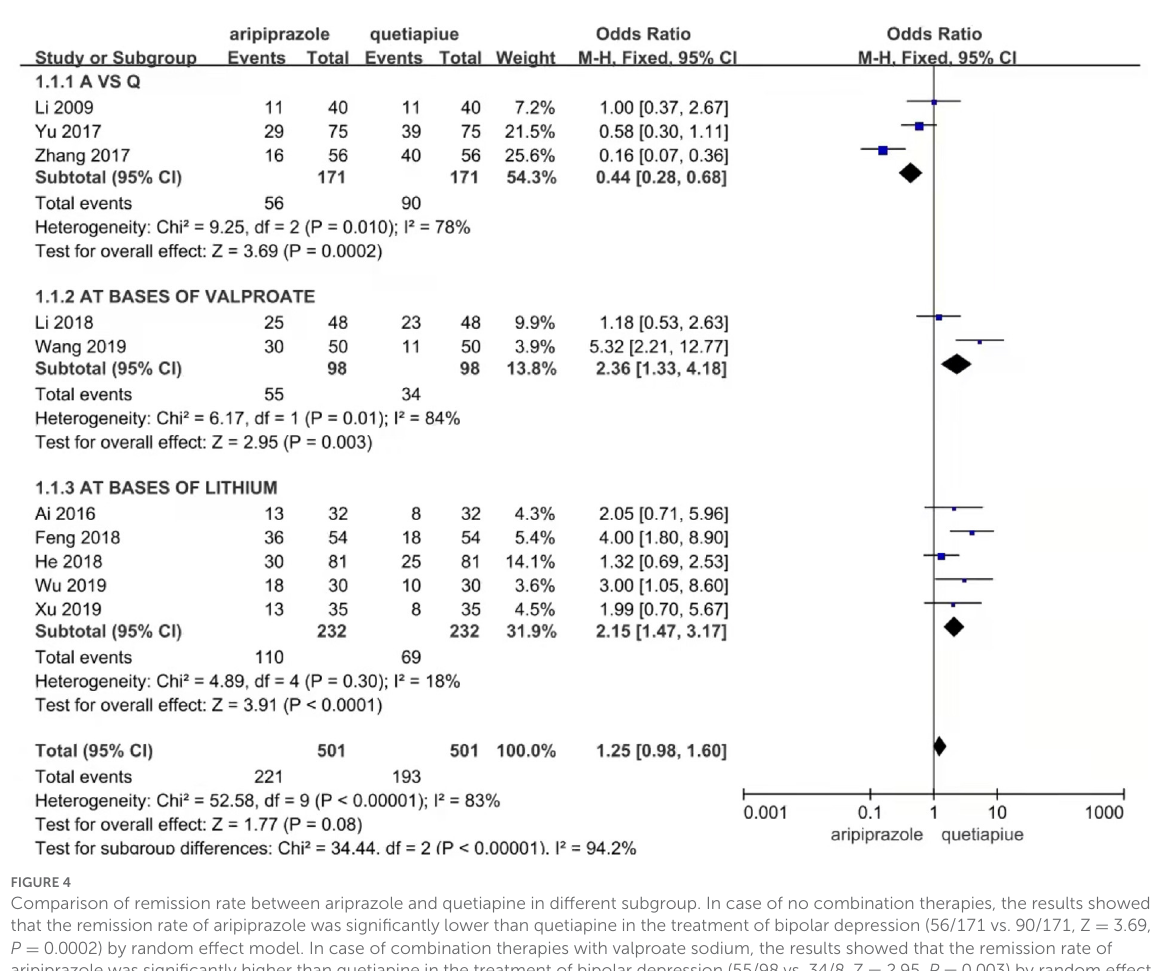
heterogeneity ( X 2 = 31.81, df = 11, p < 0.01, I 2 = 65%).